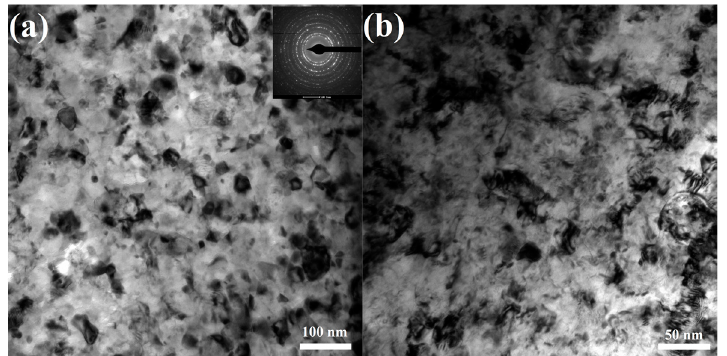
Figure 10. TEM microstructure characteristics of the wire-brushed rebar: ( a ) grain morphologies with a low magnification and selected-area electron diffraction and ( b ) detailed microstructure characteristics of the deformed nanograins with a high magnification.